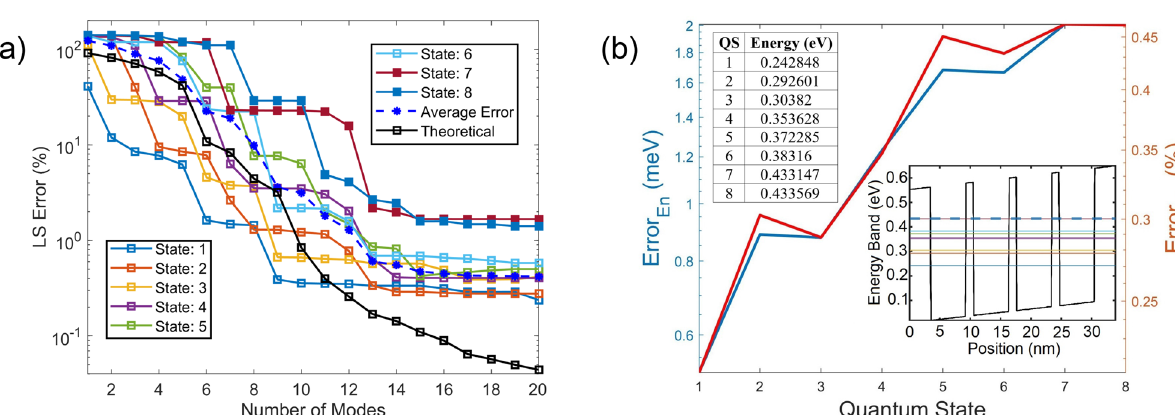
Figure 4. Profiles of | ψ | 2 in each state along ( a ) x and ( b ) y via the red dashed lines indicated in Fig. 3.